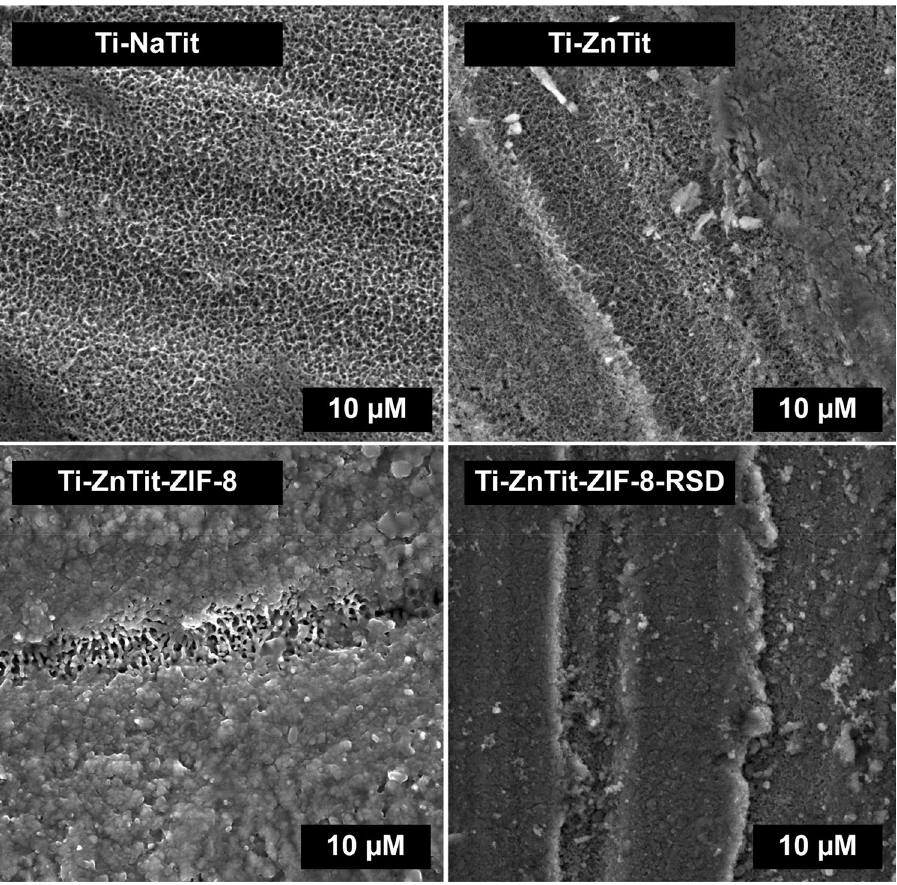
Figure 3. SEM images of Ti-NaTit, Ti-Zn-Tit, Ti-ZnTit-ZIF-8, and